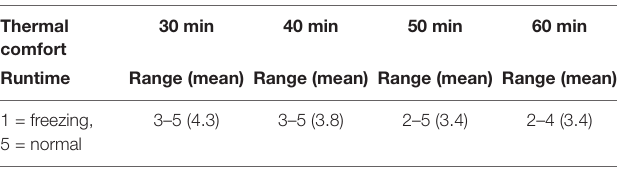
TABLE 2 | Subjective evaluation of thermal comfort on a scale of 1–10 (1 = freezing cold, 5 = thermoneutral and 10 = burning hot) was done at 10-min intervals (at run time 30, 40, 50, and 60